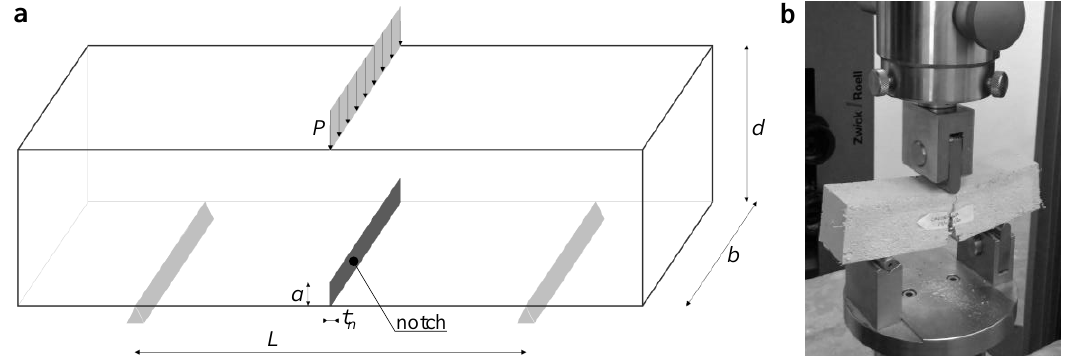
Figure 2. ( a ) notched beam adopted for the 3PBT; ( b ) picture of the 3PBT carried out at the LPMS of